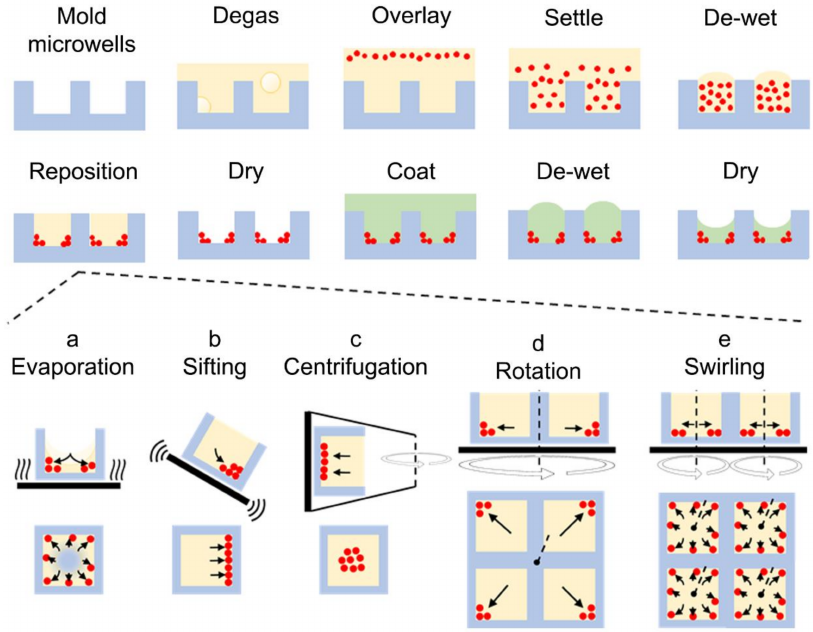
Figure 1. Overview of embedded microstructure arrays (“EMAs”) microfabrication. First, a poly- dimethylsiloxane (PDMS) microwell substrate is fabricated by soft lithography (details omitted).